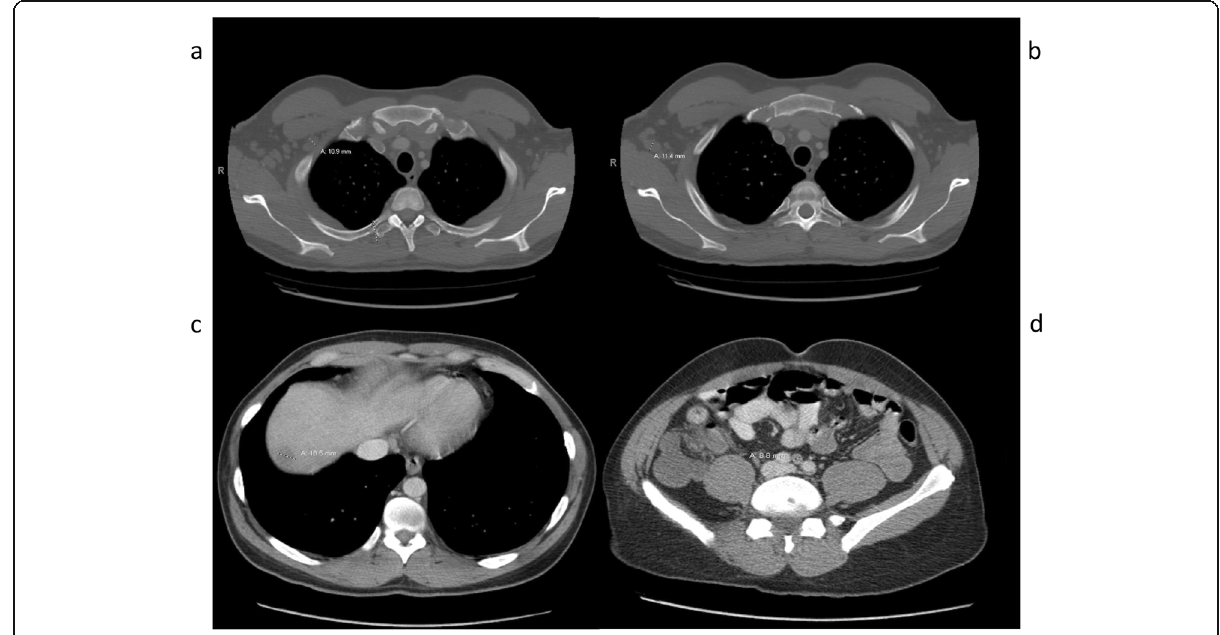
Fig. 2 Computed tomography of chest ( a , b ), abdomen ( c ), and pelvis ( d ) showing mild right axillary, with moderate right pelvic lymphadenopathy with largest lymph node measuring up to 1.8 cm short axis adjacent to the distal right external iliac vasculature. There is diffuse heterogeneous enhancement of the hepatic parenchyma with scattered nodular regions of hypoattenuation measuring up to 1.9 cm in